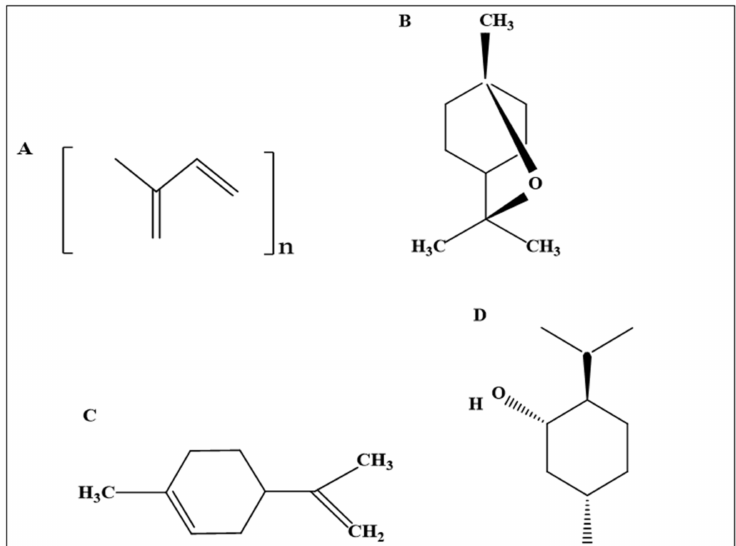
Figure 6. The chemical structure of terpenes. ( A ) The structure of isoprene and classification of terpenes (n = 1, 2, 3, 4, 6, 8; hemiterpene, monoterpene, sesquiterpene, diterpene, sesterpene, triterpene, and tetraterpene, respectively), ( B ) eucalyptol, ( C ) limonene, ( D )